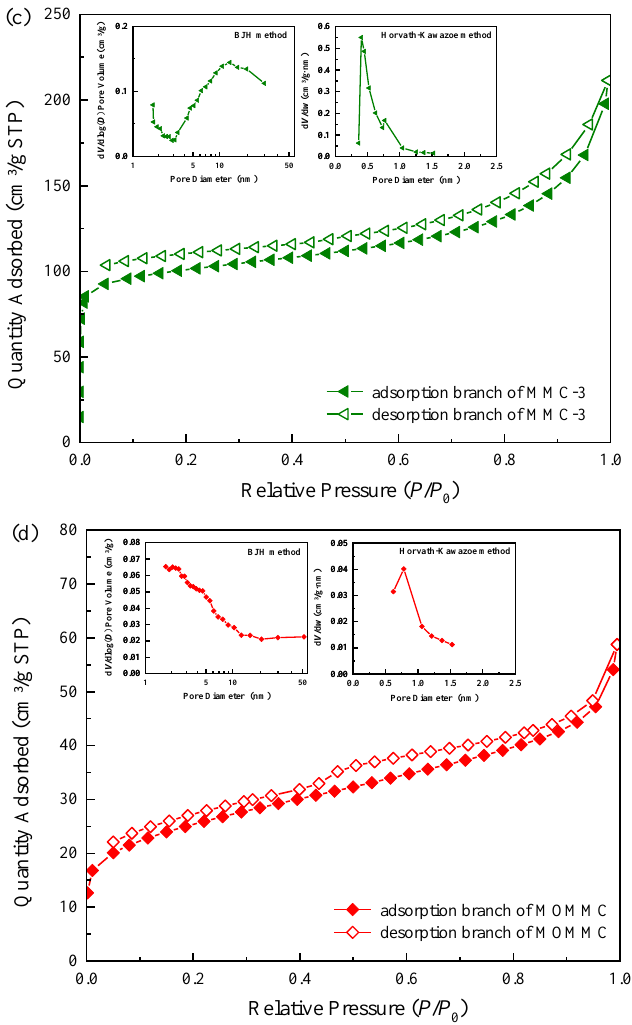
Figure 4. Nitrogen adsorption – desorption isotherms and the corresponding pore size distributions of MMC-1 ( a ), MMC-2 ( b ), MMC-3 ( c ), and MOMMC ( d ). Table 3. Pore structure parameters of MMC-1, MMC-2, MMC-3, and MOMMC.